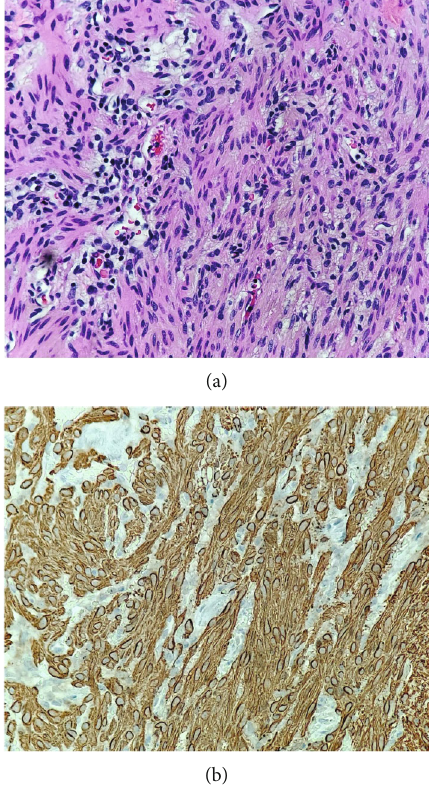
Figure 3: (a) 400x magni fi cation Hematoxylin and Eosin stain showing smooth muscle cell proliferation without atypia. (b) 400x magni fi cation showing di ff usely positive smooth muscle actin